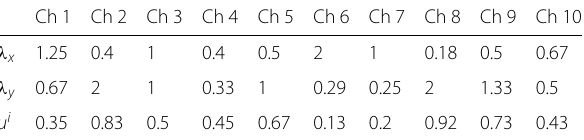
Table 2 Wireless channel